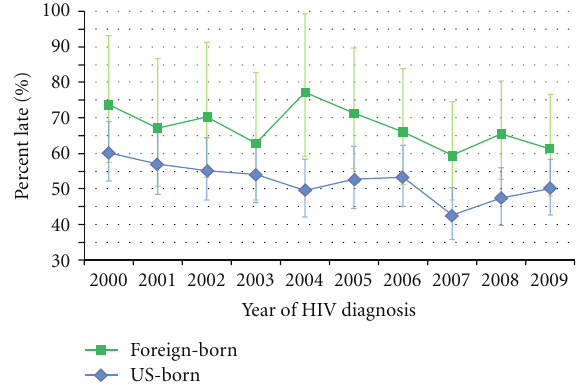
Figure 2: Trends in late HIV diagnosis (lab-based) and foreign- born status, Washington State,